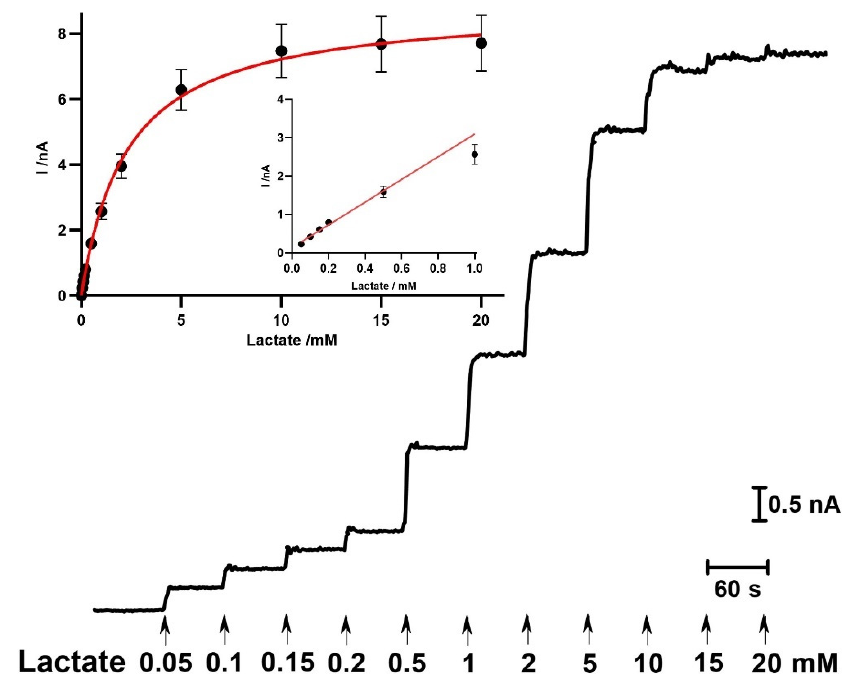
Figure 2. Enzyme kinetics of the CFM/Pt/Nafion ® -LOx(0.5%)/PU biosensor. Representative calibration showing the response to successive additions of lactate, from 0.05 to 20 mM; Inset: calibration plot of the average steady-state current as function of lactate concentration. Data were fitted to the Michaelis–Menten equation by using non-linear regression analysis; Inset: linear regression of the biosensor response to lactate (y = 2.96x + 0.14; R 2 = 0.992). Data represent mean ± SEM (n = 9). Table 2. Enzyme kinetics and analytical parameters of lactate